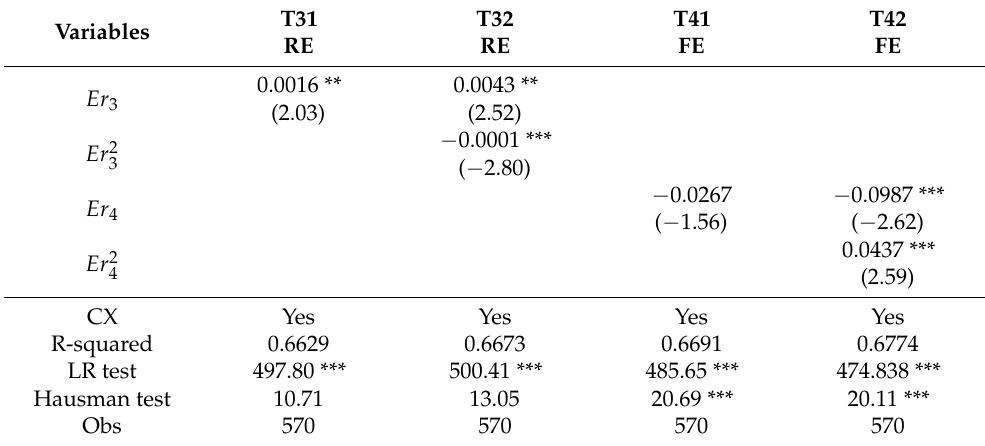
Table 5. Linear and quadratic regressions of market environmental regulations: